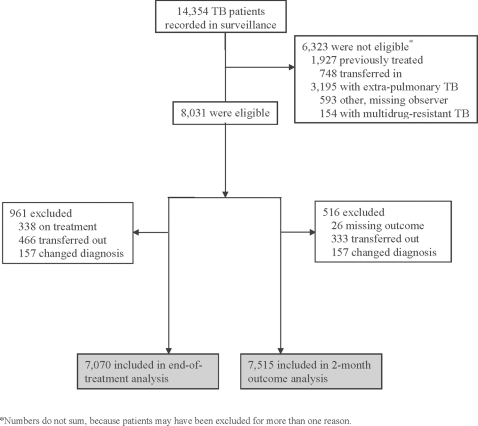
Patients included in the analysis.